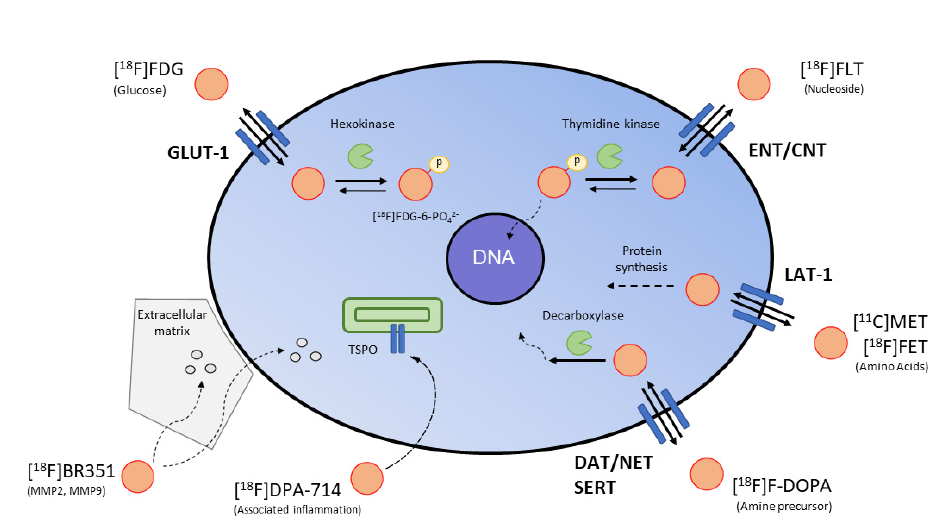
Figure 3. Surrogate imaging in oncology. Examples of key clinical PET tracers for imaging tumor metabolism, cell proliferation and tumor-associated inflammation.